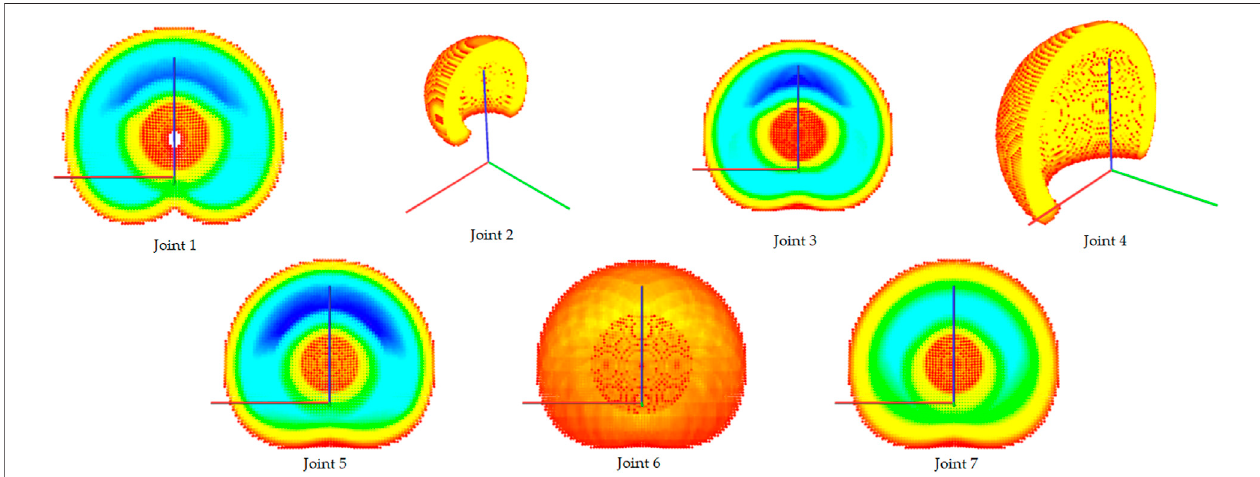
FIGURE3| CapabilitymapsfortheKUKAiiwarobotwheneachjointislockedatitszeropositionwhilealltheotherjointsarefullyoperational.Thecross-sectionisdisplayed usingthesamescaleandthesamecuttingplane(XZ),butthepointofviewischangedinsomemapstoprovideabetter3Dvisualization.Notethatafailureinjoint2or4signi fi cantly affects the workspace volume, while a failure in joints 6 or 7 reduces dexterity throughout the workspace (compare to the original capability map without failures in Figure 2 ).